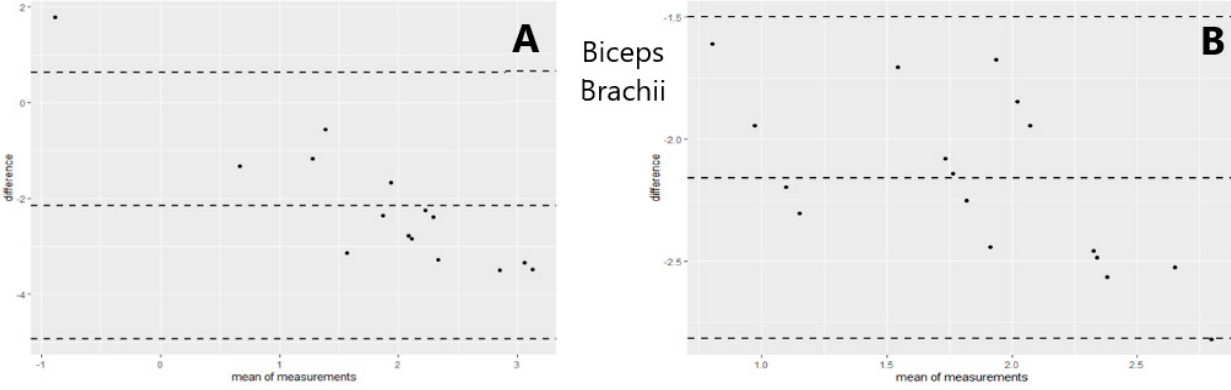
Figure 6. Differences between MRC scale and sEMG ( A ) as well as MRC and Dynamometry ( B ) for Biceps Brachii muscle versus the mean of the two measurements. The central line represents the mean difference (bias A = − 2.16; B = − 2.16), while the top and bottom lines represent the relative 95% CI (A = − 4.93; 0.62) (B = − 2.82; − 1.50). The agreement between the measures is good when the differences are randomly distributed and fall within the 95% CI. The Bland–Altman plots highlight the differences of measurements performed with the two instruments. When the points (representing the observations) are scattered within the CI, the instruments can be used interchangeably. This mean that there are no significant differences between the measurements obtained from both instruments.